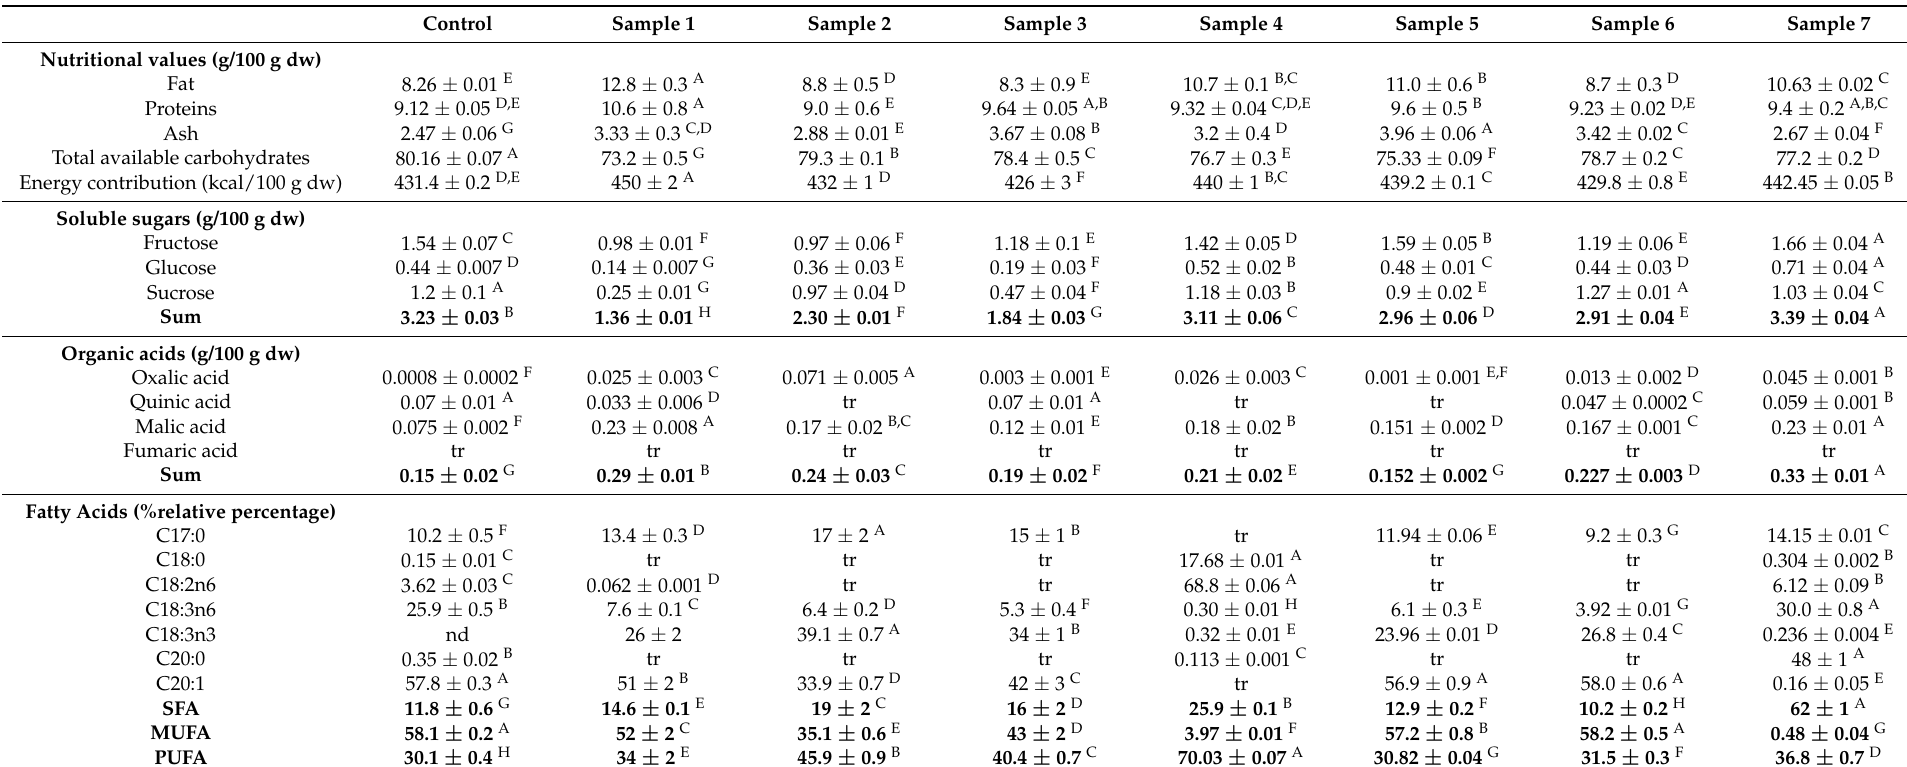
Table 7. Nutritional profile and chemical composition of the bread formulation prepared with different combinations of wheat, niger, millet and birdseed (mean ± SD results expressed on a dry weight